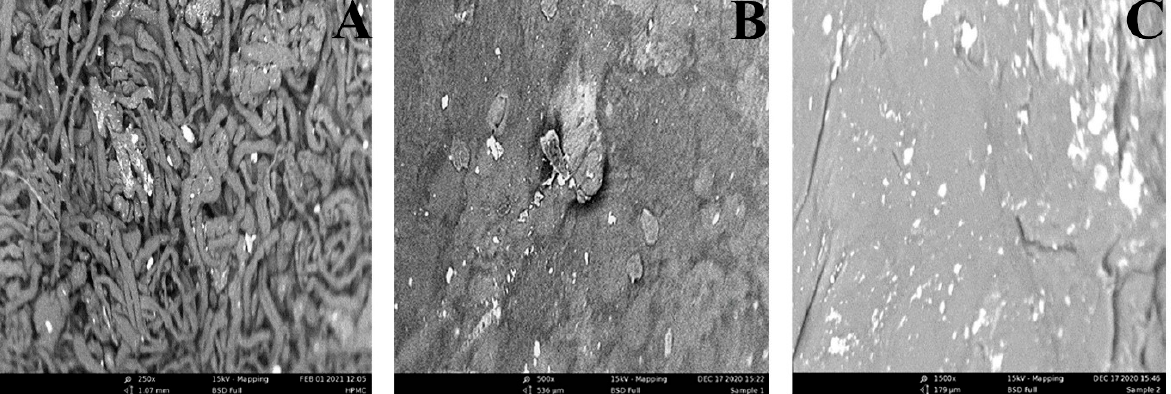
Figure 1. SEM Images of HPMC ( A ) SRF1 and ( B ) SRF2 ( C